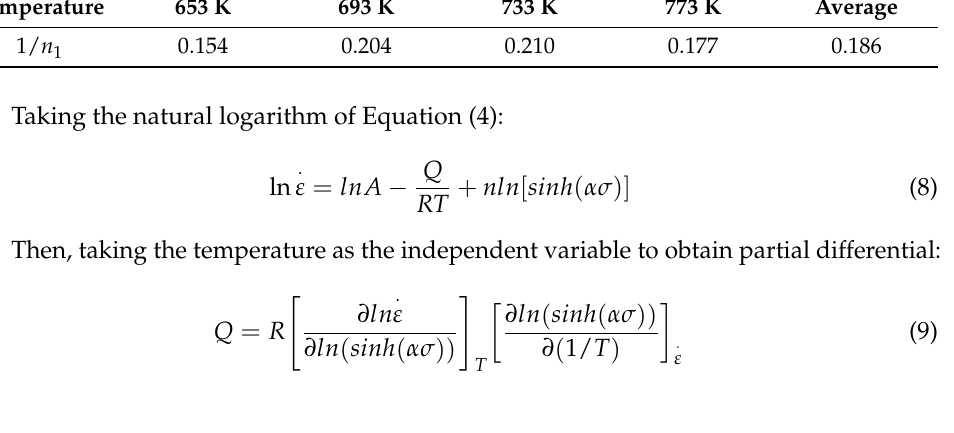
Figure 2. Fitting curve images of the peak stress and the strain rate. ( a ) Stress-ln(strain/s − 1 ); ( b ) Ln(stress/MPa)-ln(strain/s-1). Table 2. 1/ n 1 of the alloy at different temperatures.